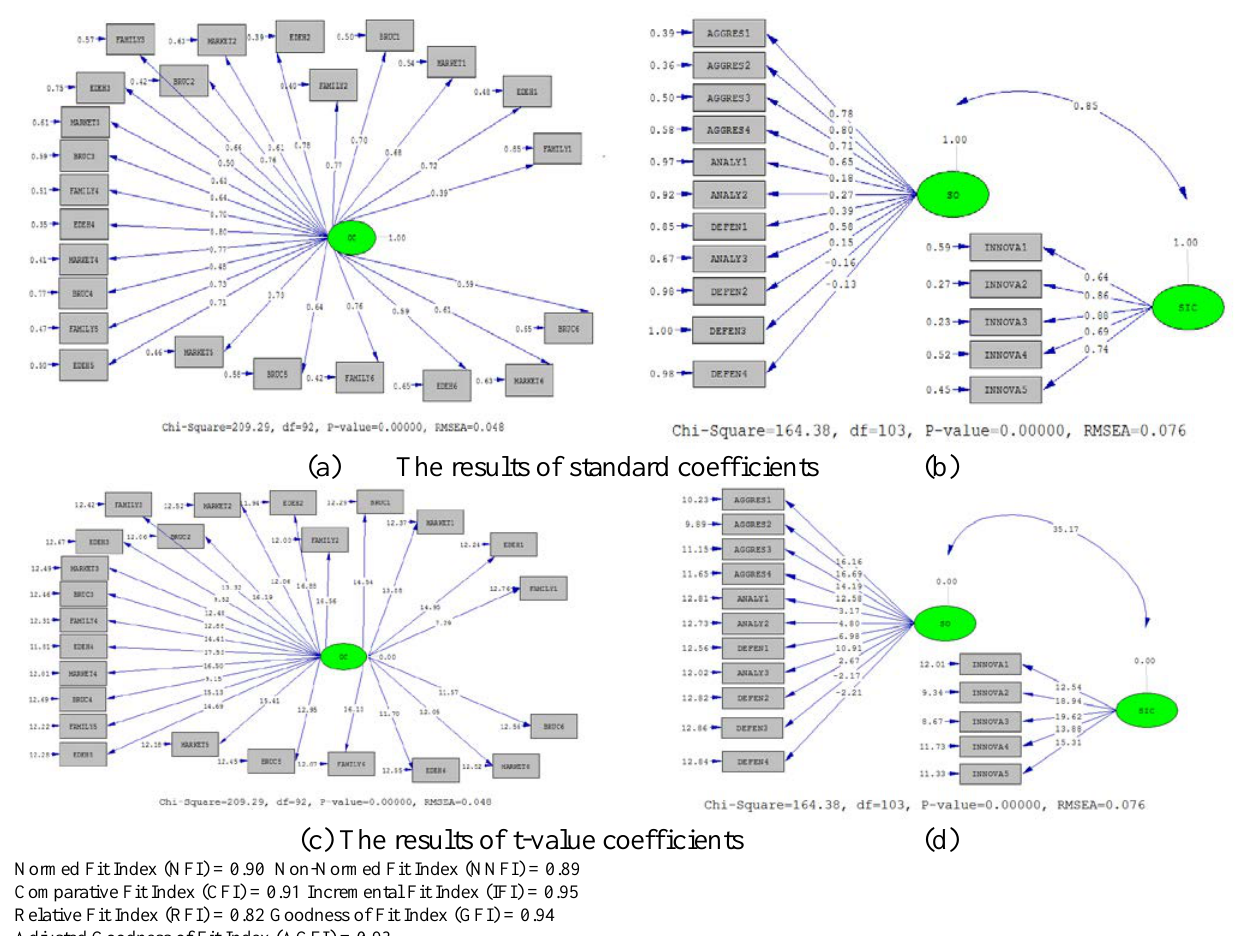
Fig. 3. The results of structural equation